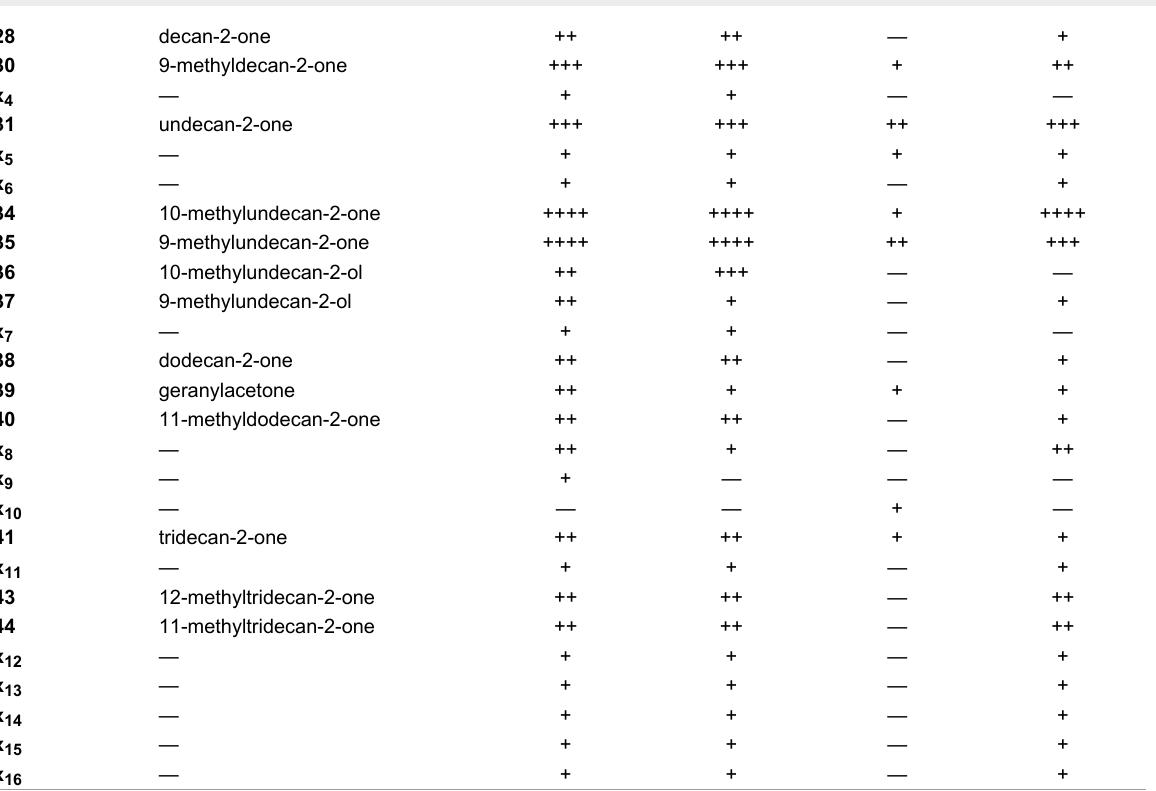
Table 2: GC/MS analysis of SPME trapped volatiles emitted from Xanthomonas campestris pv. vesicatoria 85-10 grown in a Petri dish on NB or NBG. a (continued)